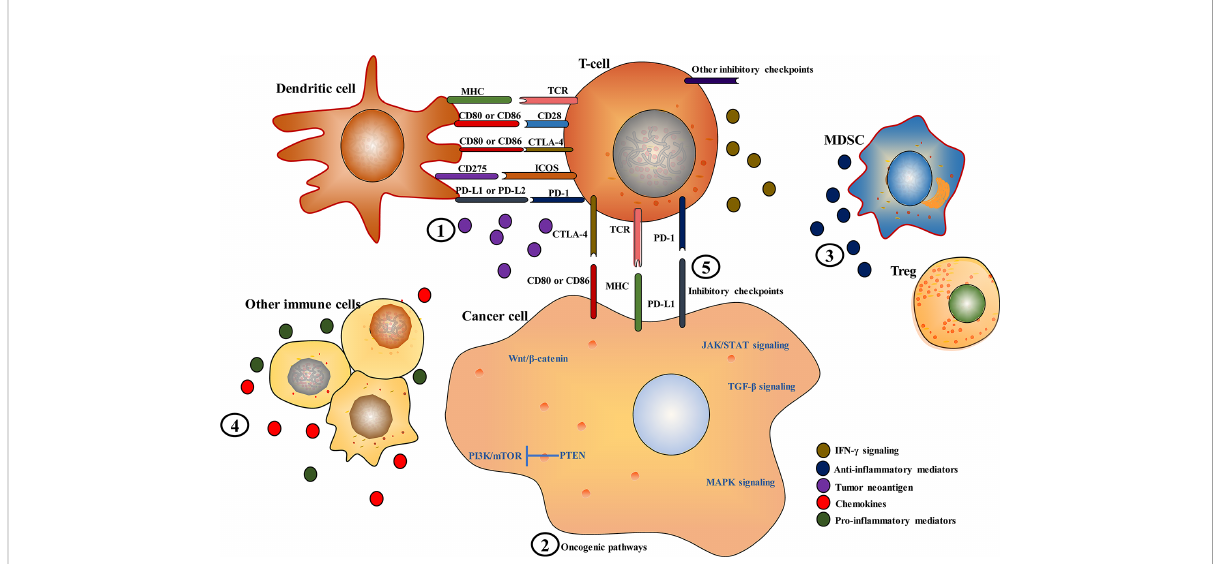
FIGURE 1 Key mechanisms of immune checkpoint inhibitor resistance in hepatocellular carcinoma. (1) Inadequate, absence or alterations in the presentation or processing of tumor neoantigens; (2) alterations in oncogenic pathways, such as phosphatidylinositol-3-kinase (PI3K)/mammalian target of rapamycin (mTOR), mitogen-activated protein kinase (MAPK), Janus kinase/signal transducer and activator of transcription (JAK/STAT), Wnt/ b - Catenin, and transforming growth factor beta (TGF- b ) signaling pathways; (3 and 4) polarization toward an immunosuppressive microenvironment by reducing pro-in fl ammatory mediators and increasing anti-in fl ammatory mediators; (5) other novel immune checkpoint molecules, such as T-cell immunoglobulin and ITIM domain (TIGIT), lymphocyte activation gene-3 (LAG-3), T-cell immunoglobulin and mucin-domain containing-3 (TIM-3), B7 homolog 3 protein (B7-H3), B and T lymphocyte attenuator (BTLA), V-domain immunoglobulin suppressor of T cell activation (VISTA), and inducible T-cell costimulatory